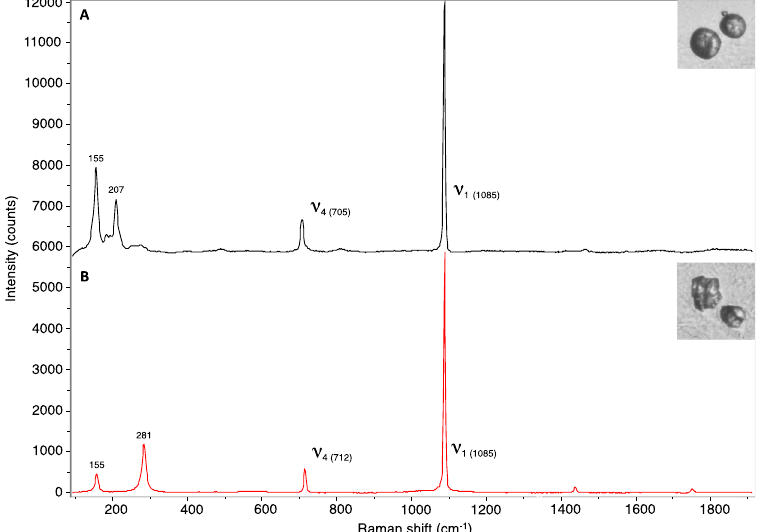
Figure 3. Raman spectroscopy of round and irregular otoliths. Raman spectroscopy profiles for aragonitic round otoliths ( A ) and calcitic irregular otoliths ( B ) in gilthead sea bream larvae exposed to pH7.3. Typical calcium carbonate ν 1 and ν 4 peaks are indicated and the shift position of each peak is indicated in brackets. Representative round and irregular otoliths are shown for each spectrum. Spectrums are showed separately in order to facilitate the visualization of the different